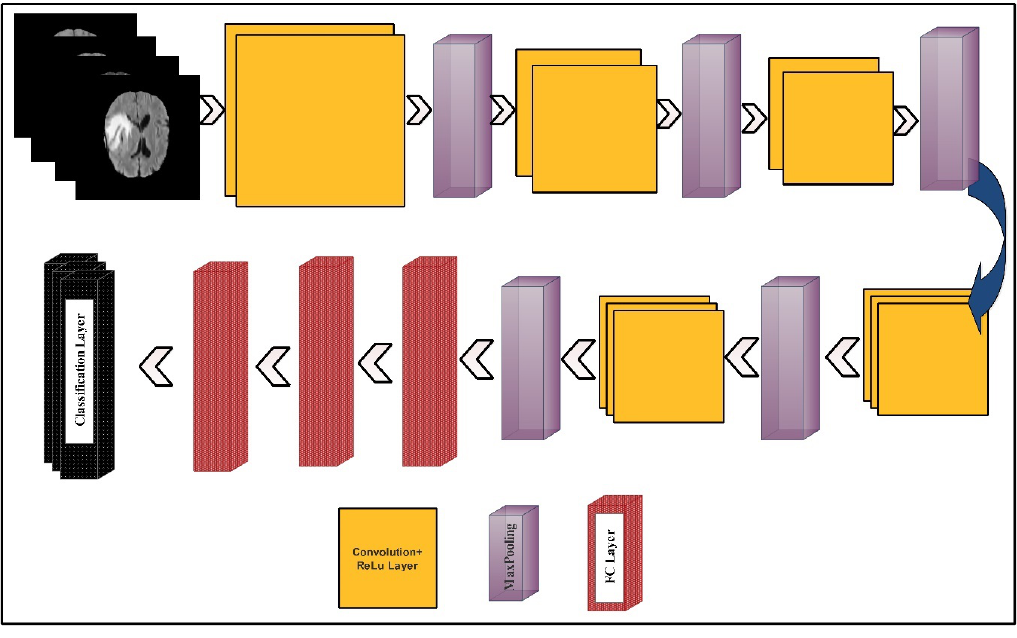
Figure 4. A layered wise architecture of the VGG16 deep learning model.